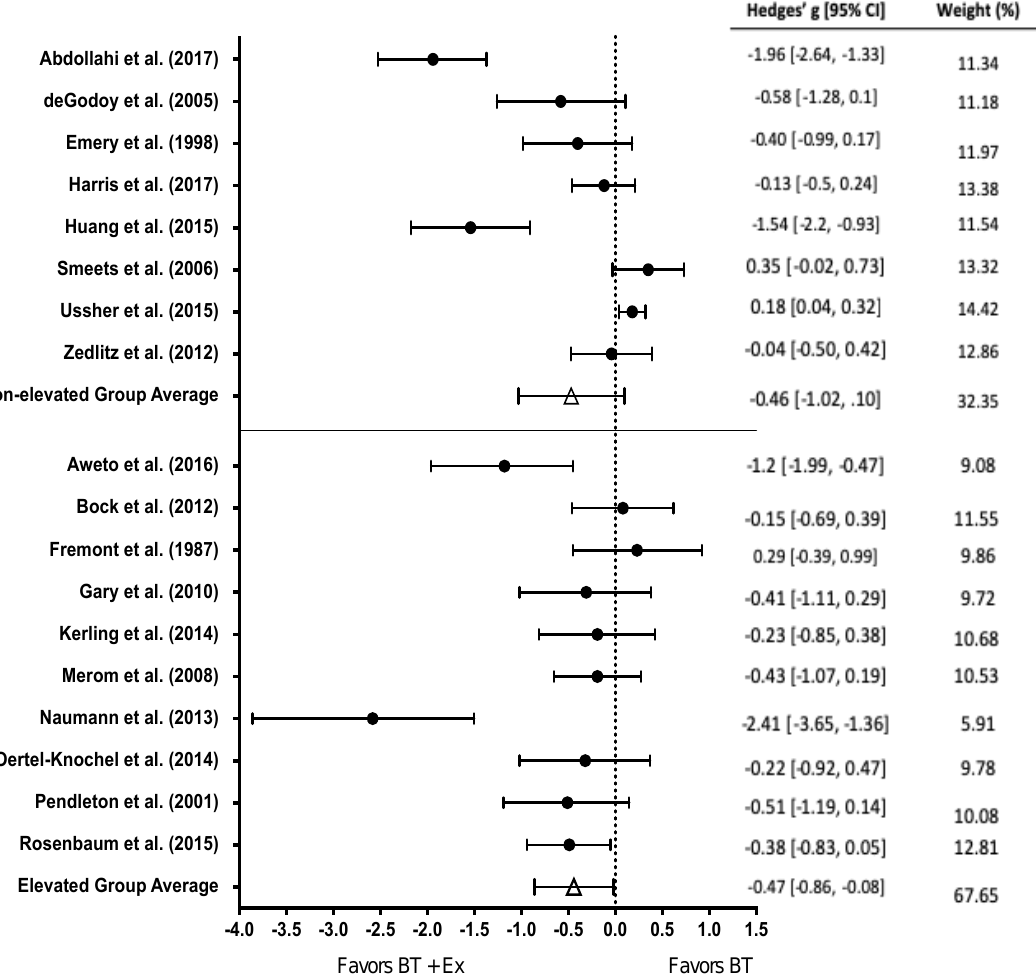
Figure 5. Subgroup analysis of non-elevated (top) and elevated baseline depression levels (bottom) among studies that measured depression. Test for overall effect of non-elevated baseline depression g = −0.46, p > 0.05. Test for overall effect of elevated baseline depression g = −0.47, p < 0.05. BT+Ex = Behavioral Therapy + Exercise, BT = Behavioral Therapy only.